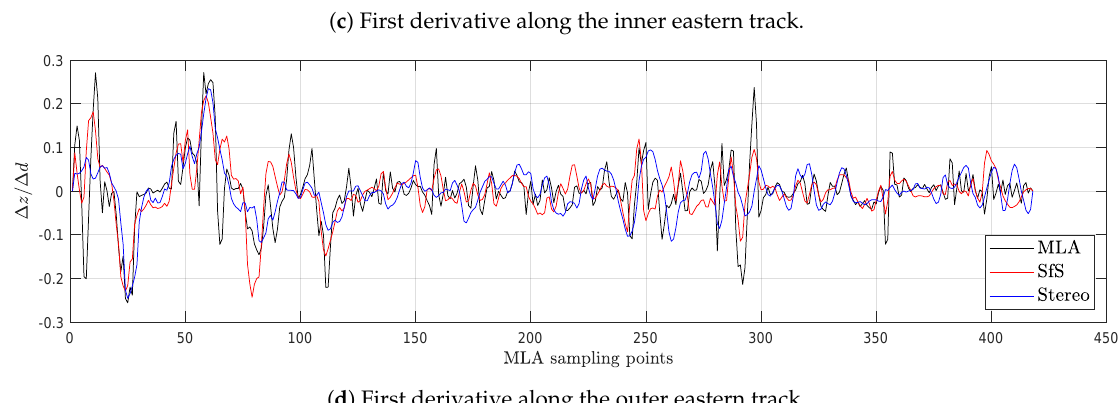
Figure 18. Comparison of the derivative along the MLA tracks (black) to the derivative of the surface constructed by the SfS procedure (red) and the initial stereo DTM (blue) of the tectonic fault. The positions of the tracks are given in Figure